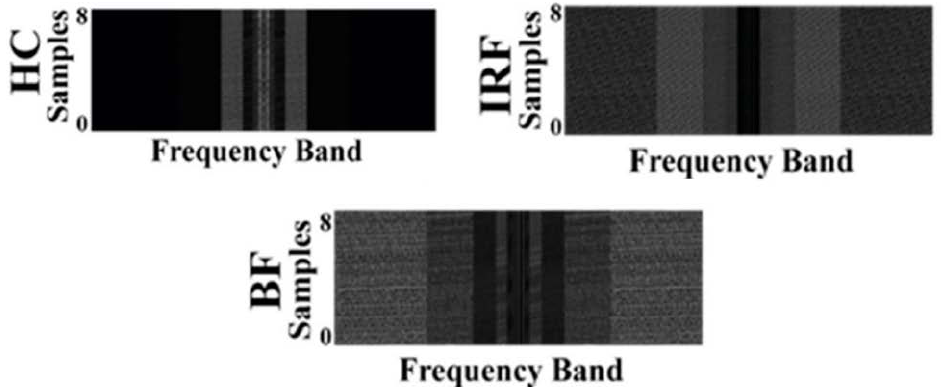
Figure 41. Vibration-based images from discrete orthogonal Stock-well transform (DOST) for a bearing’s healthy conditions (HC),inner race fault (IRF), and ball fault (BF) [112].